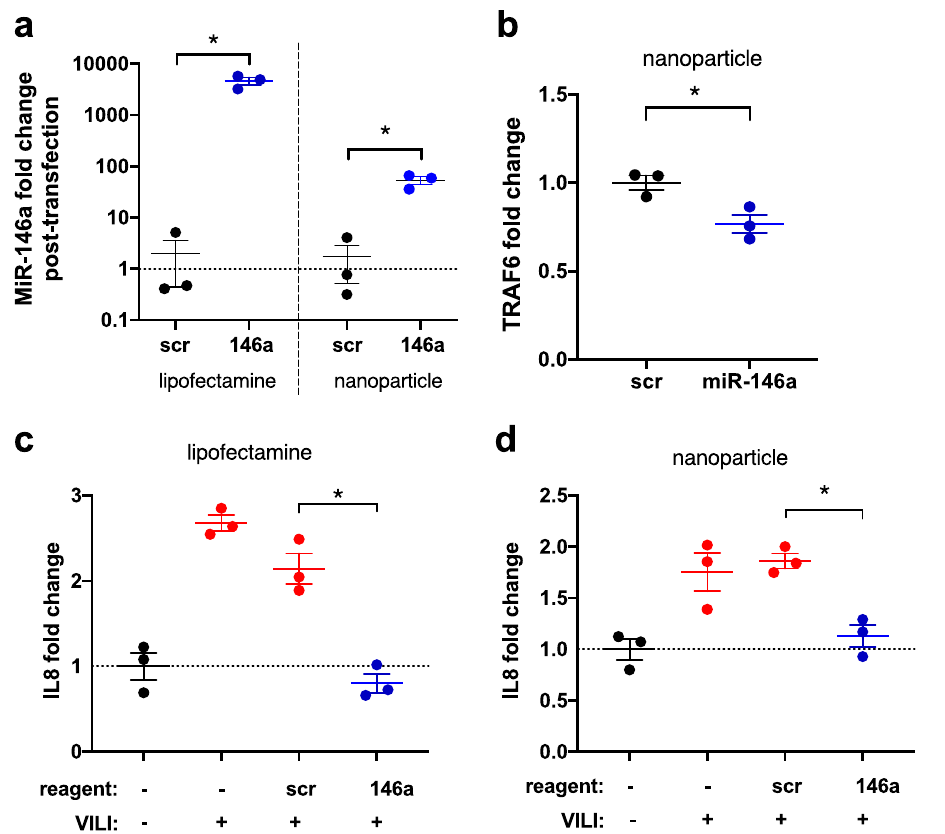
Fig. 5 miR-146a overexpression dampens force-induced in fl ammation in vitro. a miR-146a expression in alveolar macrophages (AMs) subjected to barotrauma following lipofectamine (left panel) or nanoparticle (right panel) transfection with pre-miR-146a, calculated by ΔΔ Ct method, normalized to scramble controls. Lipofectamine data log-normally distributed, p = 0.0006 via two-tailed Student ’ s t -test comparing log 2 (fold change), n = 3 per